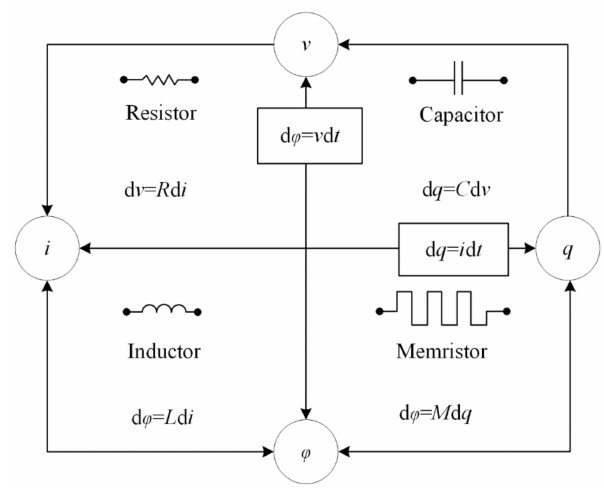
Figure 2. The four fundamental two-terminal circuit